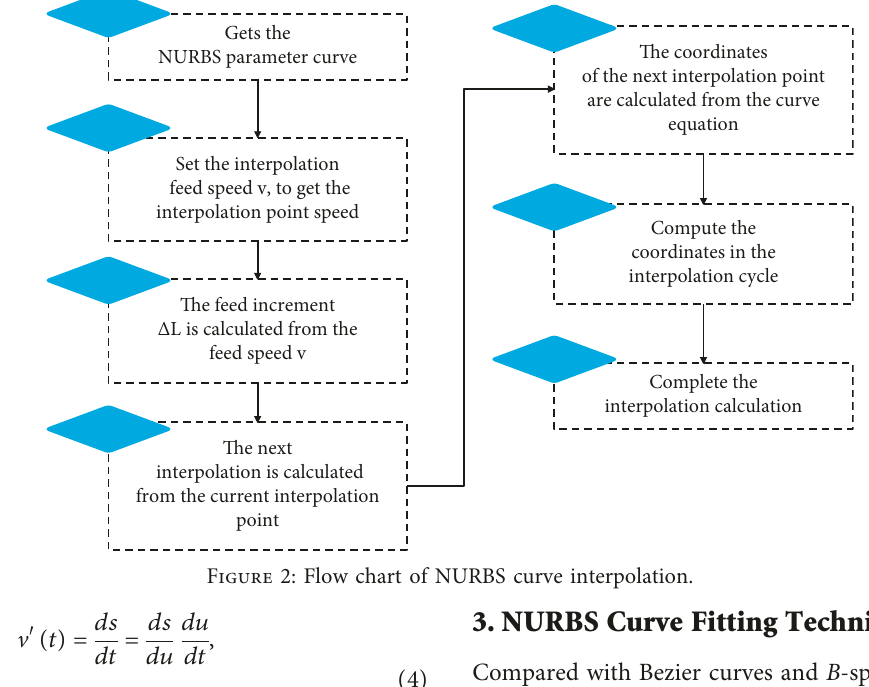
Figure 2: Flow chart of NURBS curve